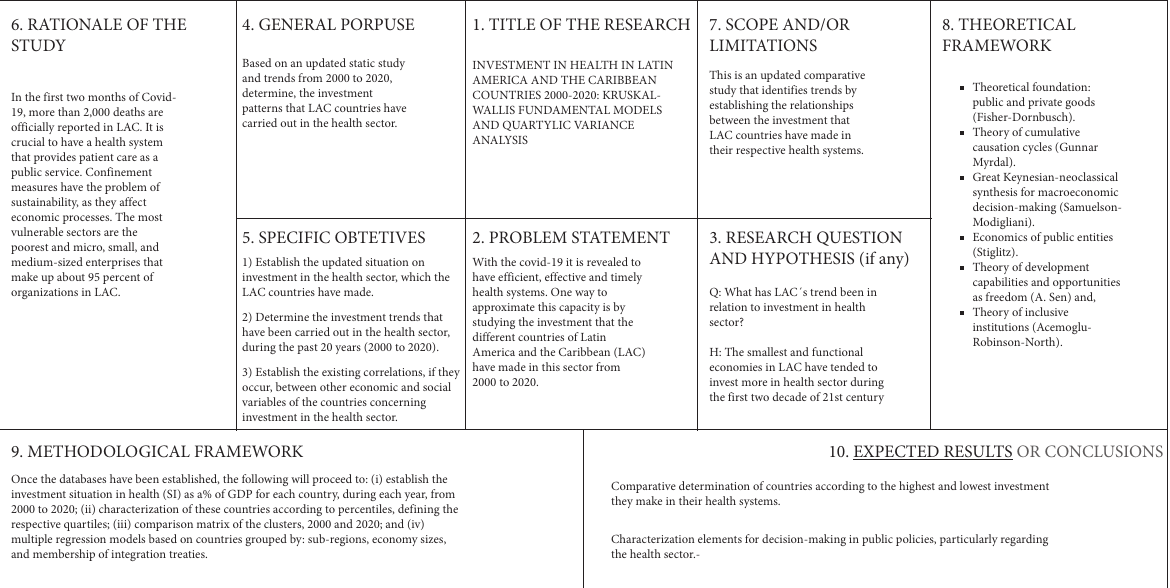
Figure 6: Practical example of the Canvas Model for Research Projects (CMRP). Elaborated by Socorro and Reyes. November